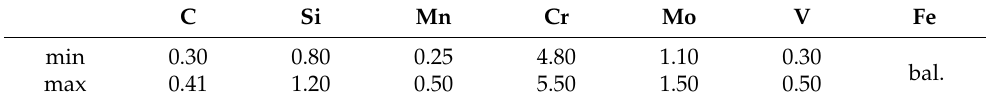
Figure 1. Powder particle size distribution (PSD) of the employed fine M4P H11 powder and the coarse TLS H11 powder. Table 1. Chemical composition in wt.% of the employed H11 tool steel powders.